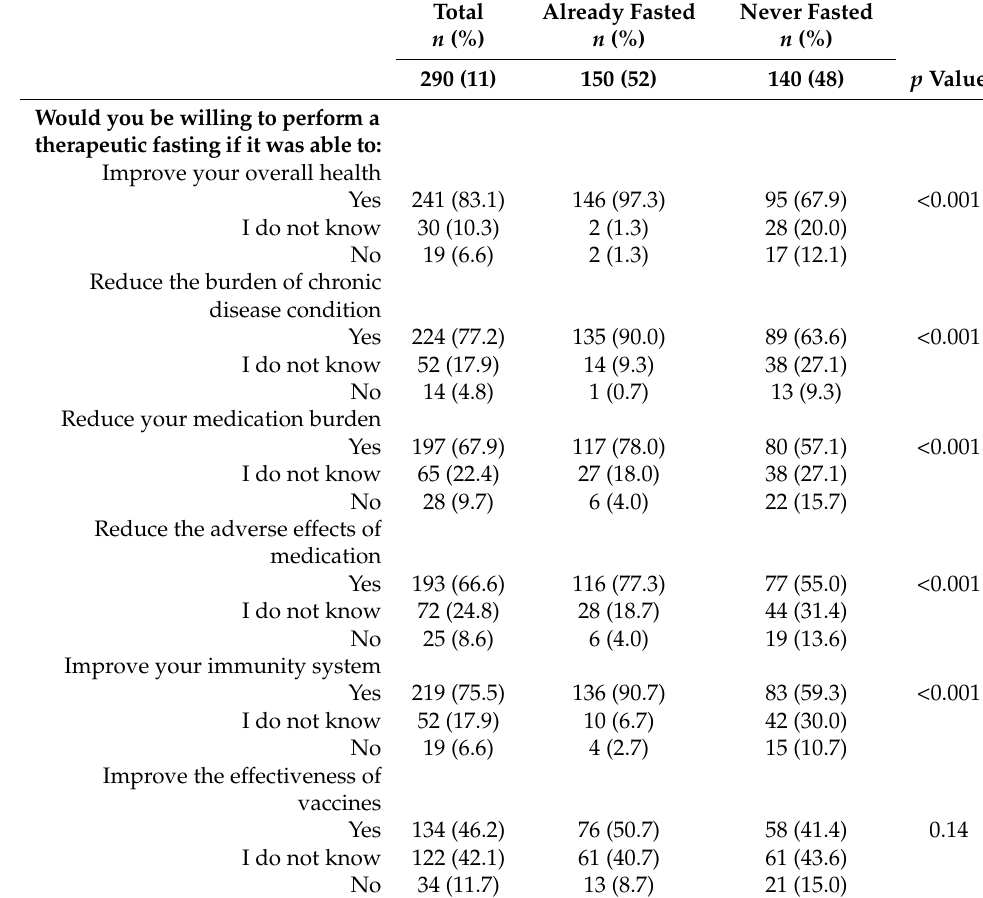
Table 3. The comparison of different attitudes toward fasting-mimicking diet-like